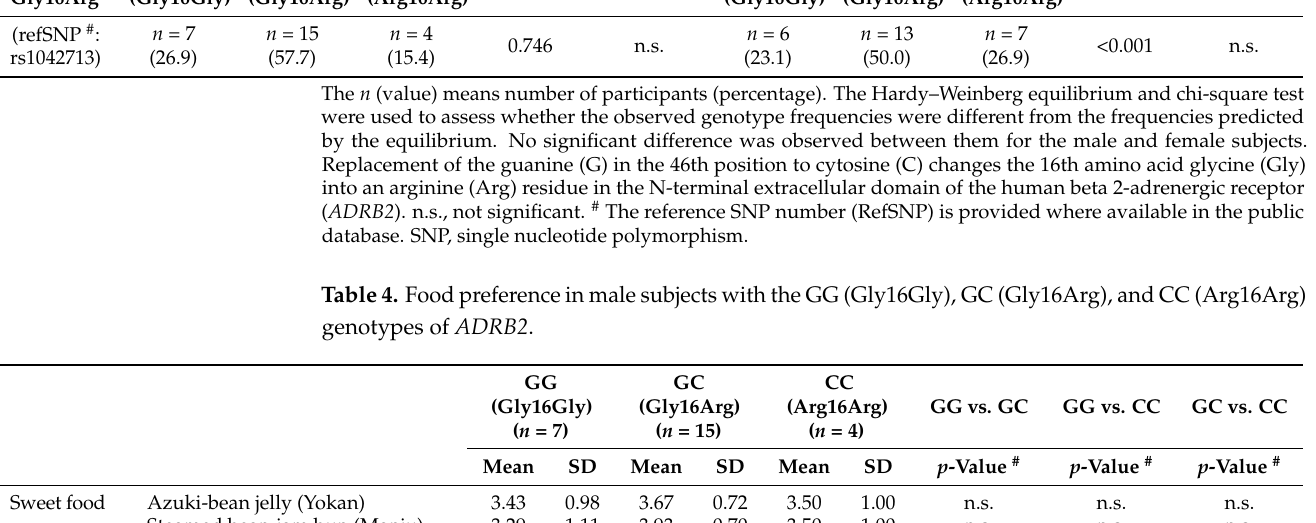
Chi-Square Test Ratio of Genotypes